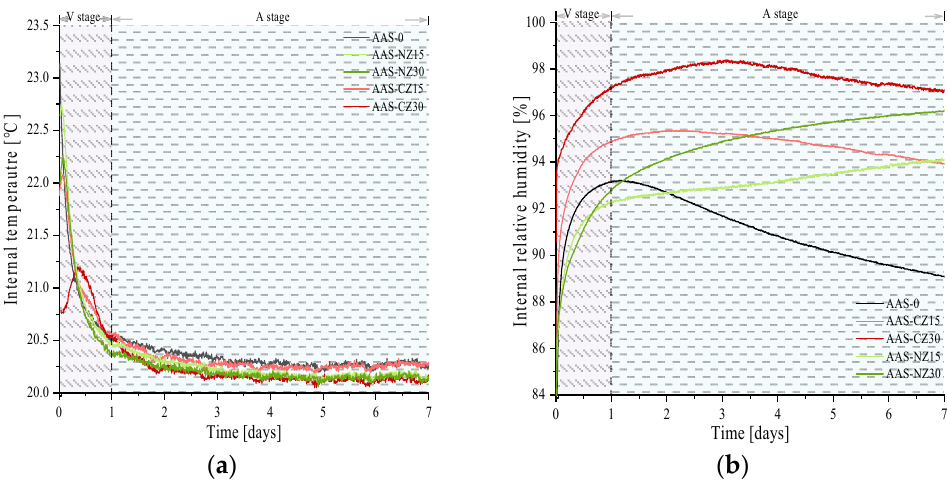
Figure 4. Relationship between the internal temperature ( a ) and internal relative humidity ( b ).